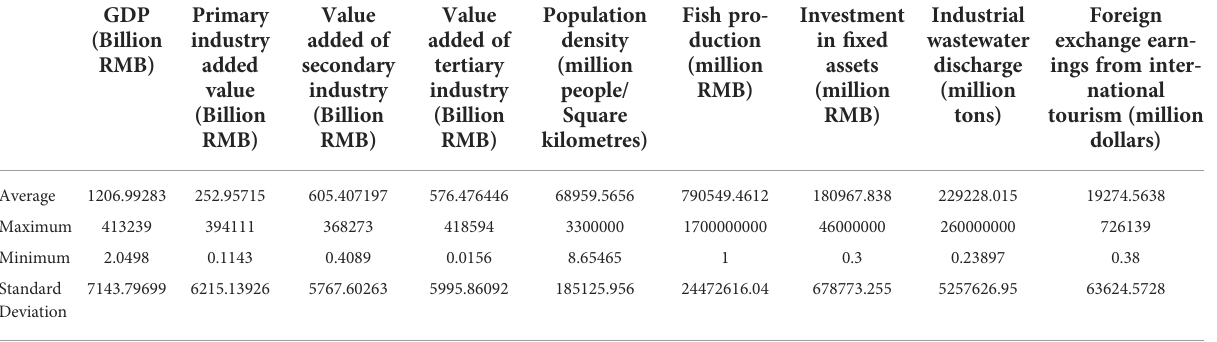
TABLE 3 Distribution of the total sample